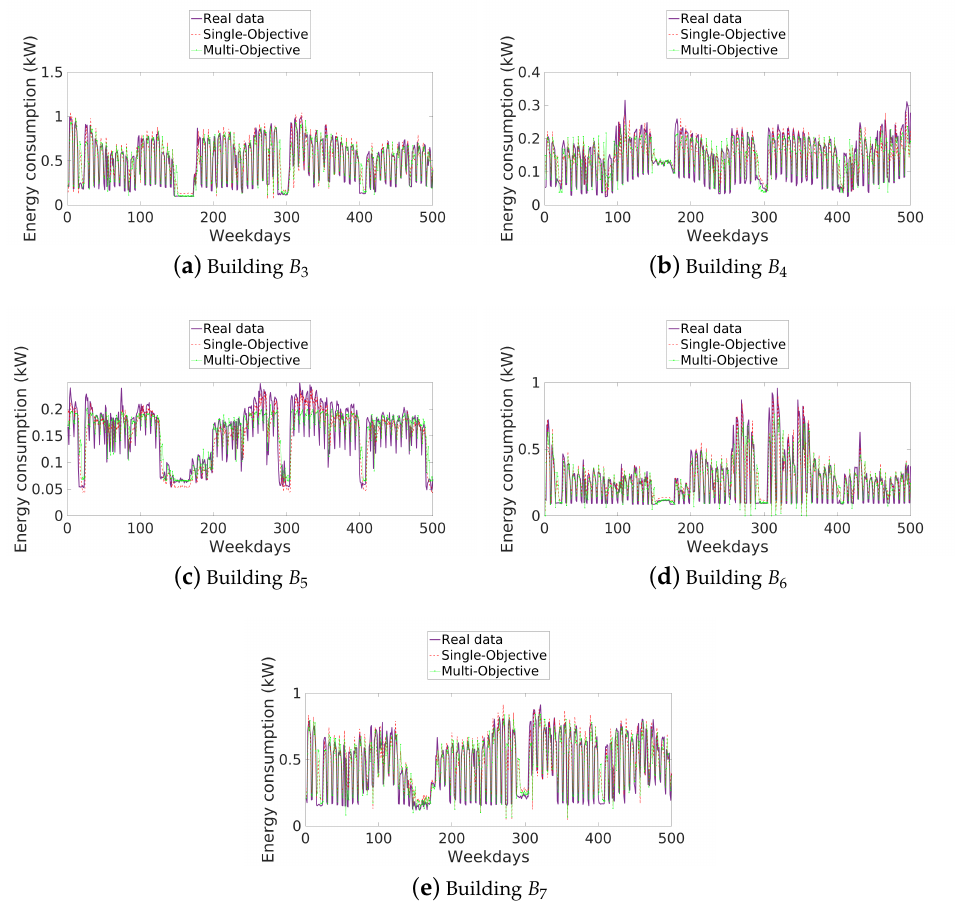
Figure 10. Real and predicted energy consumption from both single- and multi-objective approaches in cluster of buildings E 2